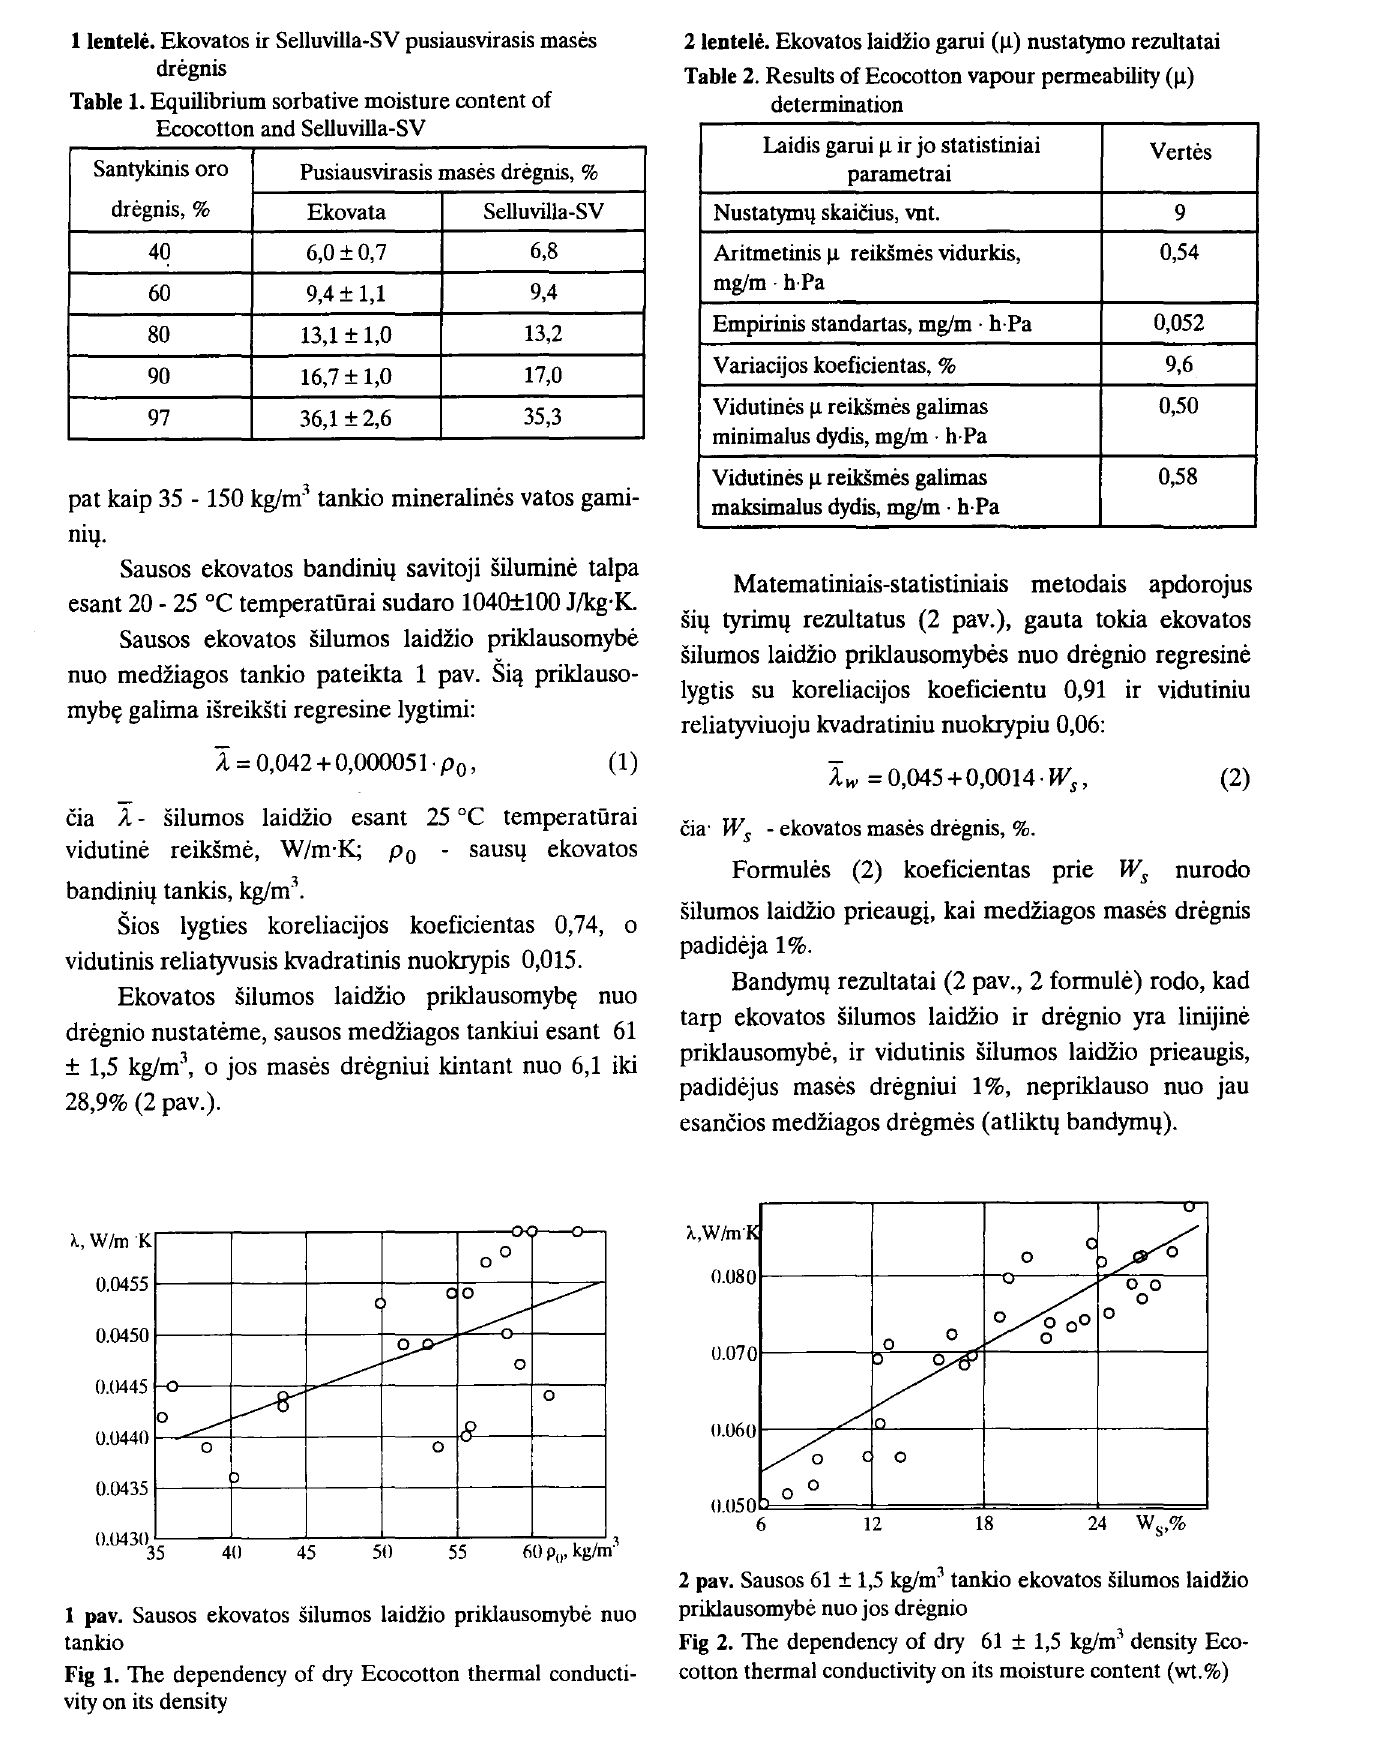
Fig 2. The dependency of dry 61 ± 1,5 kg/m 3 density Eco cotton thermal conductivity on its moisture content (wt.%)